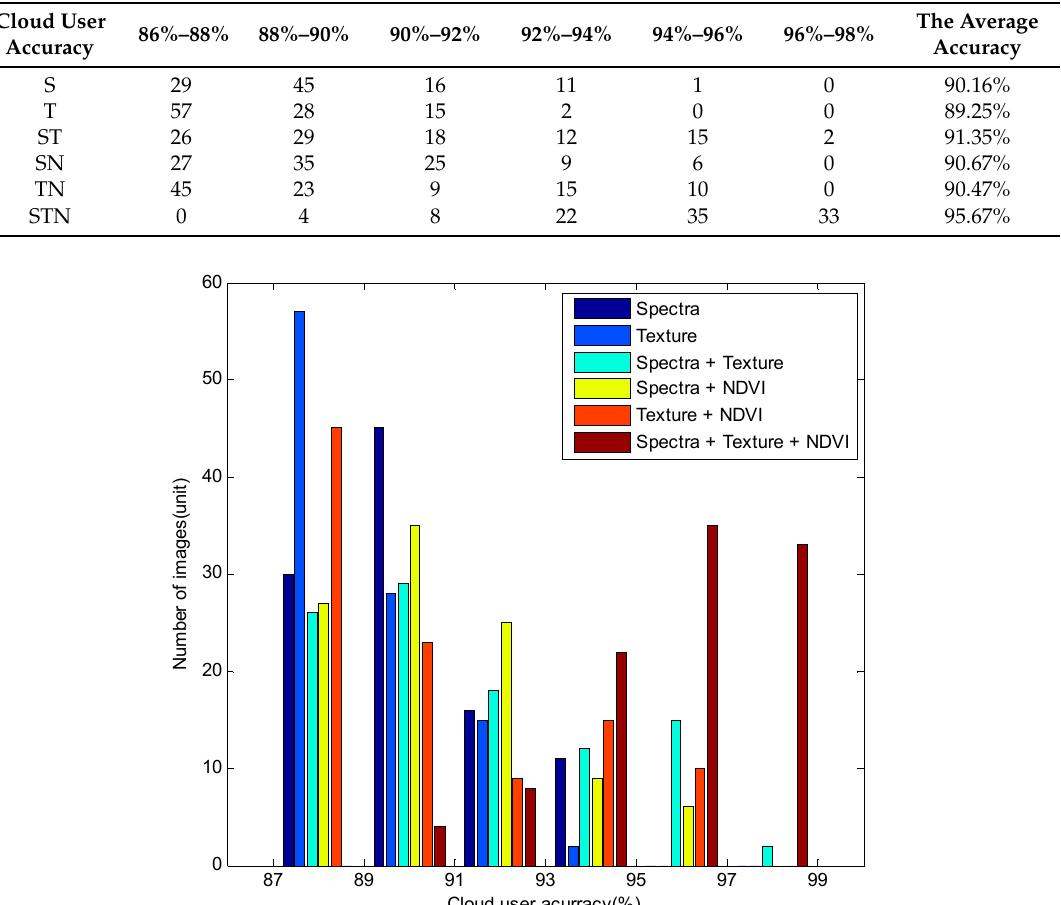
Figure 10. Bar of cloud user accuracy for S, T, ST, SN, TN, and STN feature fusion on 102 GF-1/2 images.